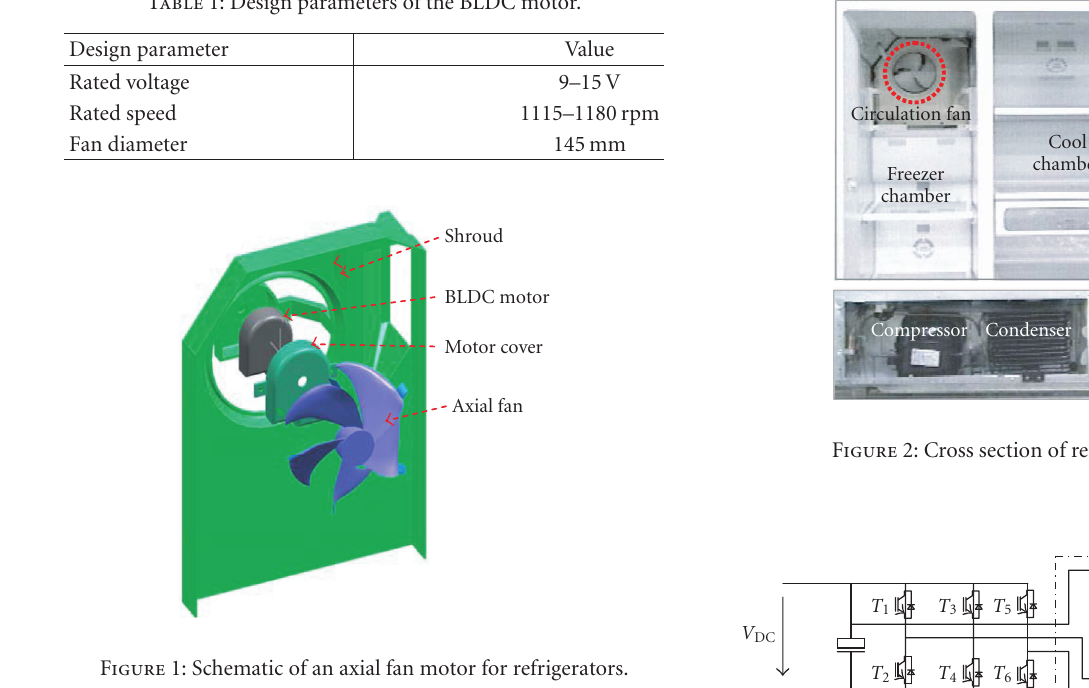
Figure 1: Schematic of an axial fan motor for refrigerators.